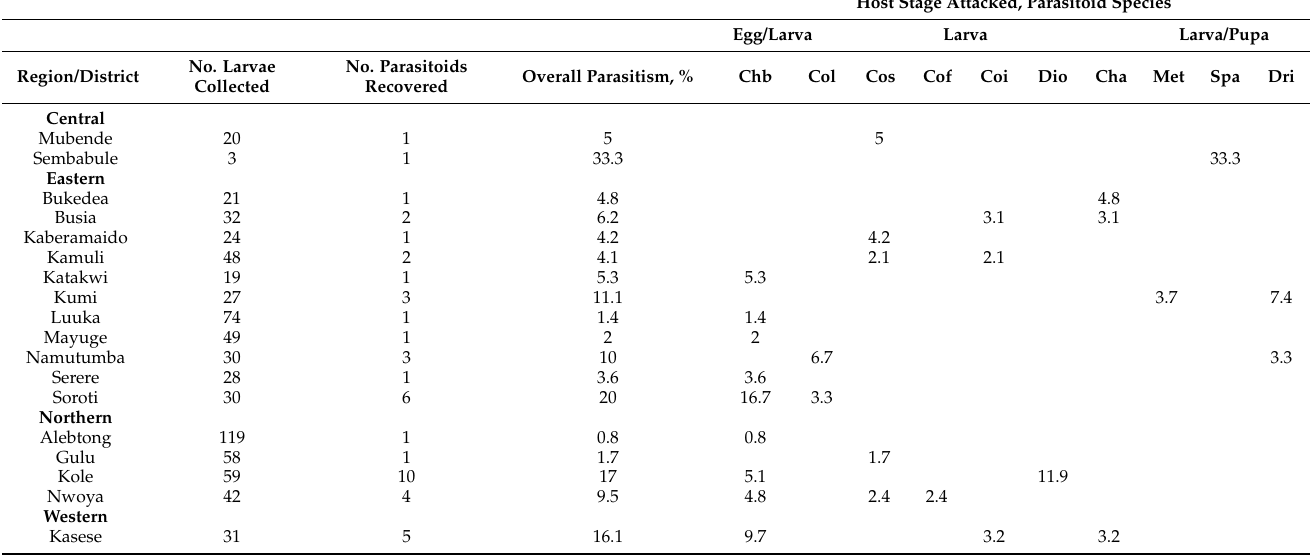
Table 4. Total larvae and parasitism of Spodoptera frugiperda larvae collected from different districts of Uganda in 2019. No. par = total parasitoids recovered; Para = parasitism; Chb = Chelonus bifoveolatus ; Col = Coccygidium luteum ; Cos = Coccy- gidium sp.; Cof = Cotesia flavipes ; Coi = Cotesia icipe ; Dio = Diolcogaster sp.; Met = Meteorus sp.; Chd = Charops cf. diversipes ; Spa = Sturmiopsis parasitica ; Dri = Drino quadrizonula . Host Stage Attacked, Parasitoid Species Egg/Larva Larva